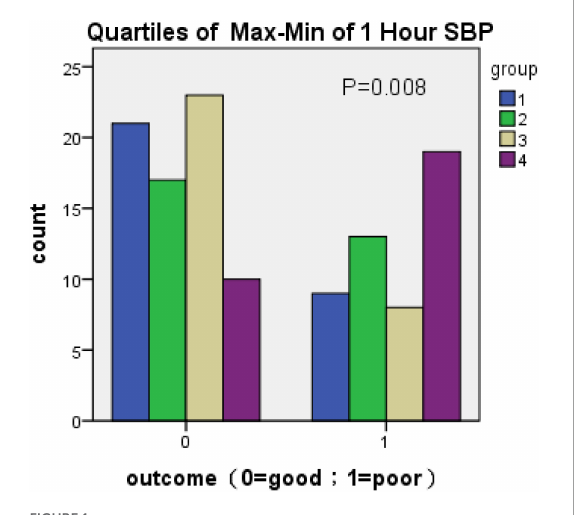
FIGURE1 Quartiles of Max-Min of 1-h SBP (outcome: 0 = good; 1 = poor).